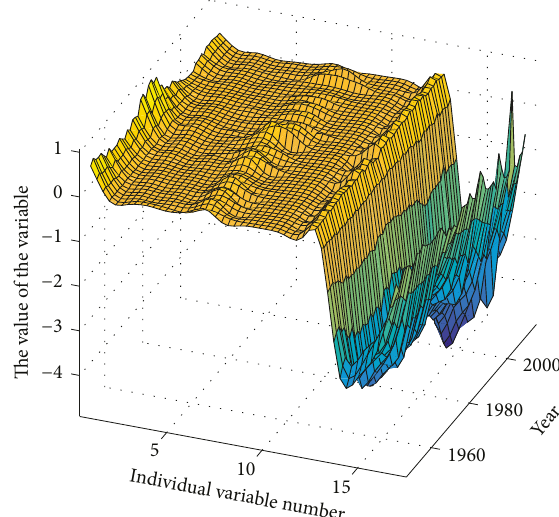
Figure 3: The 3D view of the independent variables in the experimental data.